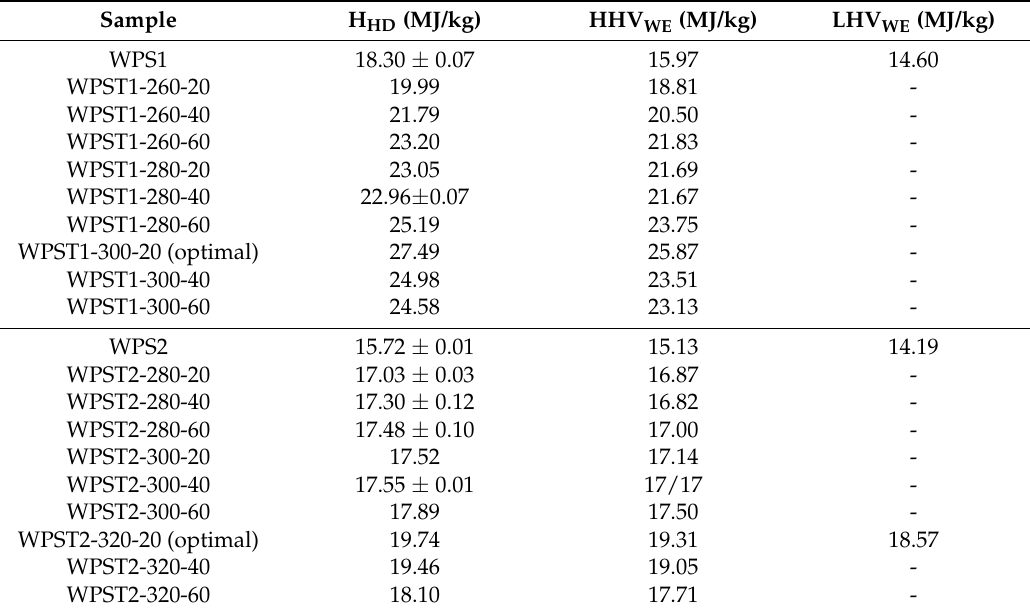
Table 2. Heating values of WPS and torrefied WPS of WPST at different torrefaction